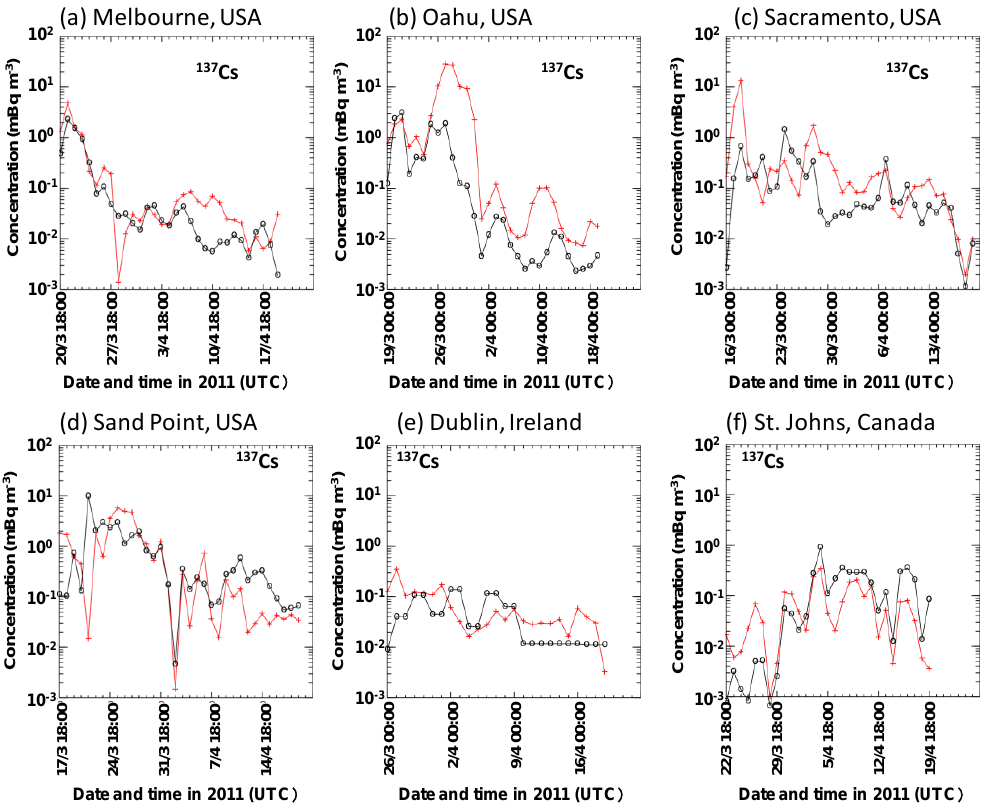
Figure 20. Temporal changes in observed (lines with open circles) and modeled (lines with crosses) air concentrations (mBqm − 3 ) using HYSPLIT with the new source term for air concentration of 137 Cs at selected CTBTO, US EPA, and European stations from 13 to 31 March 2011.